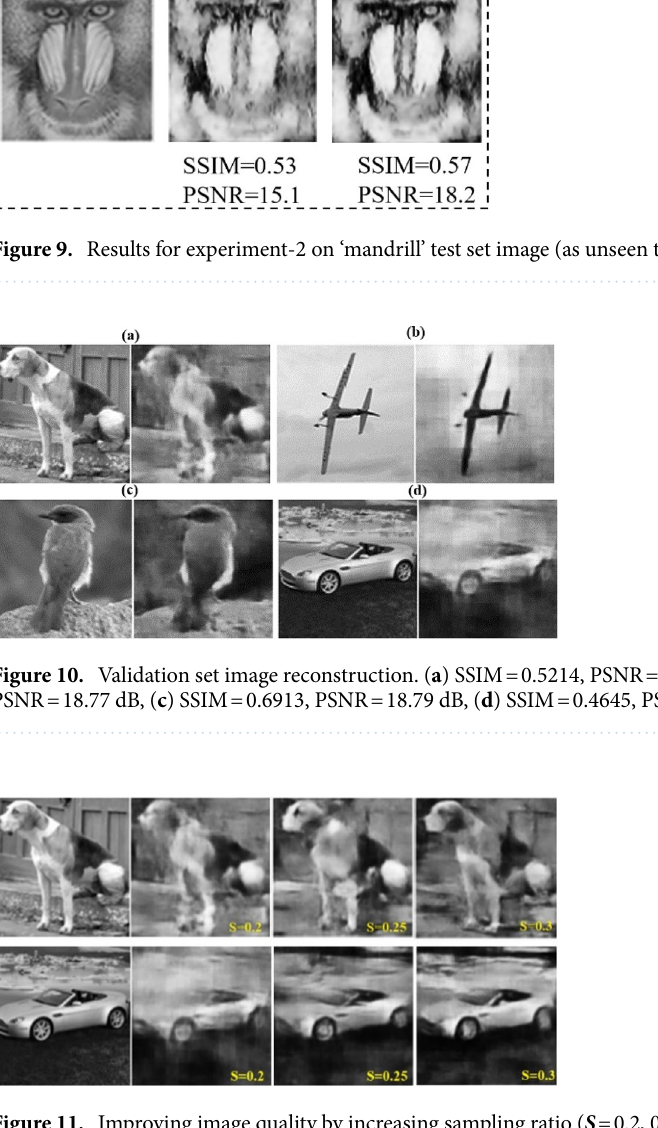
Figure 11. Improving image quality by increasing sampling ratio ( S = 0.2, 0.25, and